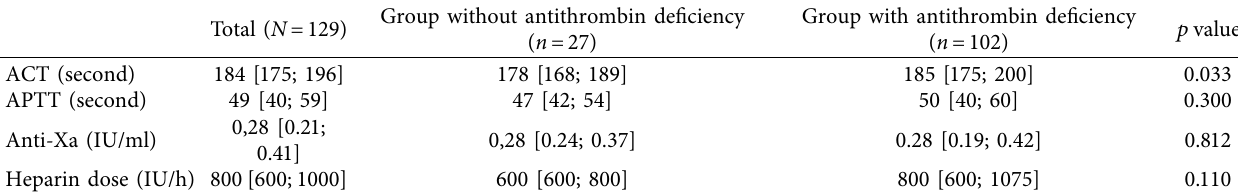
Table 1: ACT, APTT, anti-Xa, and UFH dose